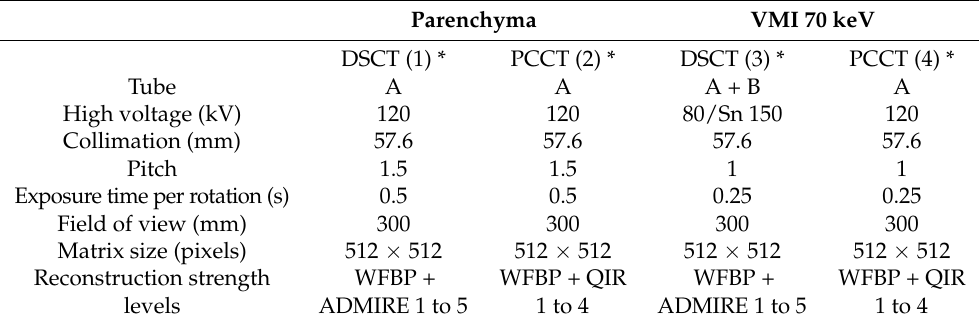
Table 1. Acquisition and reconstruction parameters for the PCCT and DSCT scanners.